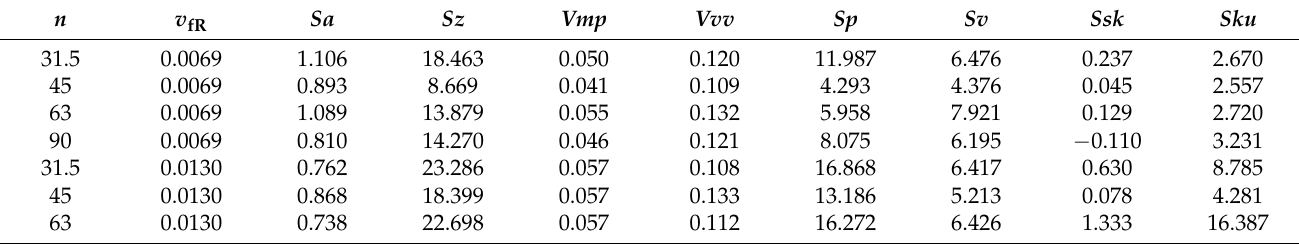
Table A5. Topography parameter data for